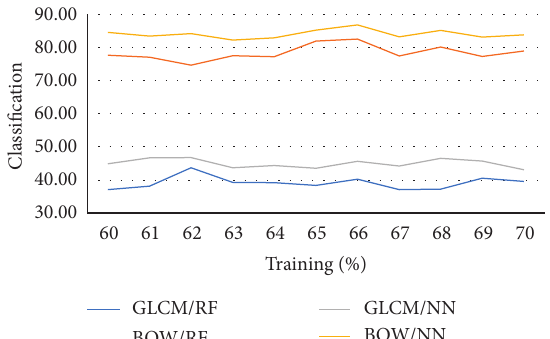
Figure 16: The classification results of GLCM and BOW methods using 60% to 70% of the training data (FEI dataset) and the classification performance of NN and RF.